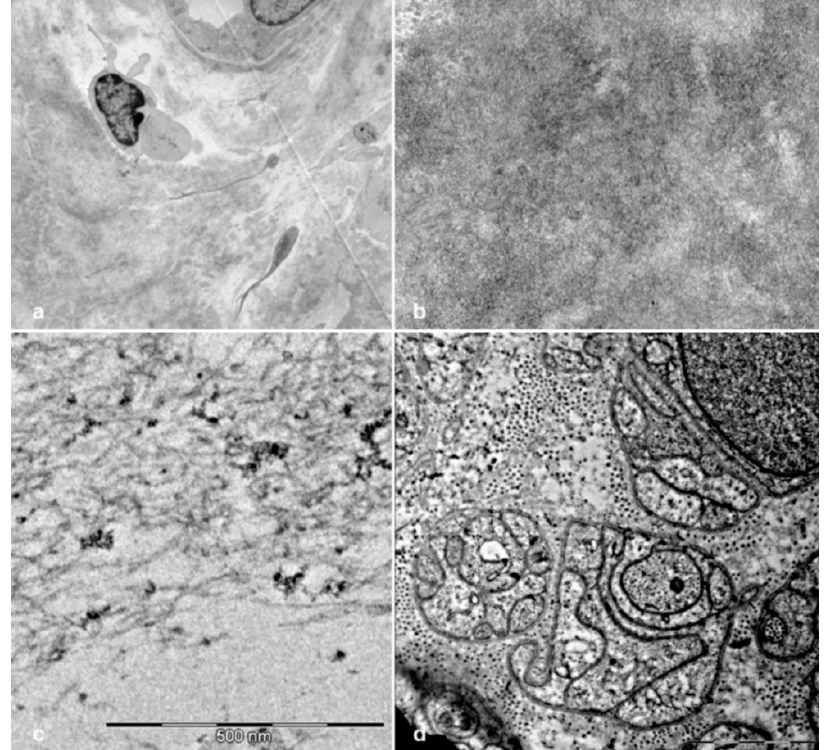
Figure 8. Electron microscope examination of sural nerve biopsies from hATTR patients. Ultrathin sections stained with uranyl acetate and lead citrate. Amyloid deposits are evident in a biopsy from a 65 ‐ year ‐ old Val30Met patient ( a , b ). Amyloid from a 73 ‐ year ‐ old Val30Met patient shows typical fibrillar structure ( c ). Unmyelinated fibers from a 74 ‐ year ‐ old Phe64Leu patient are reduced and replaced by collagen pockets ( d ).